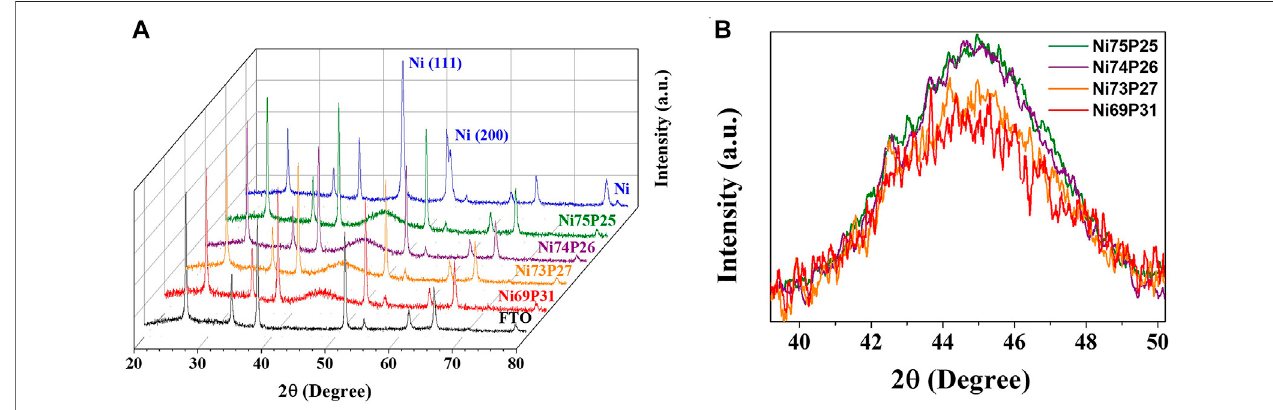
FIGURE3|(A) XRDpatternsofthepulse-reversedelectrodepositedNi-Pwithtailored compositionand (B) thebroadpeaksaround44 ° withamorphousphaseas a function of phosphorous contents.